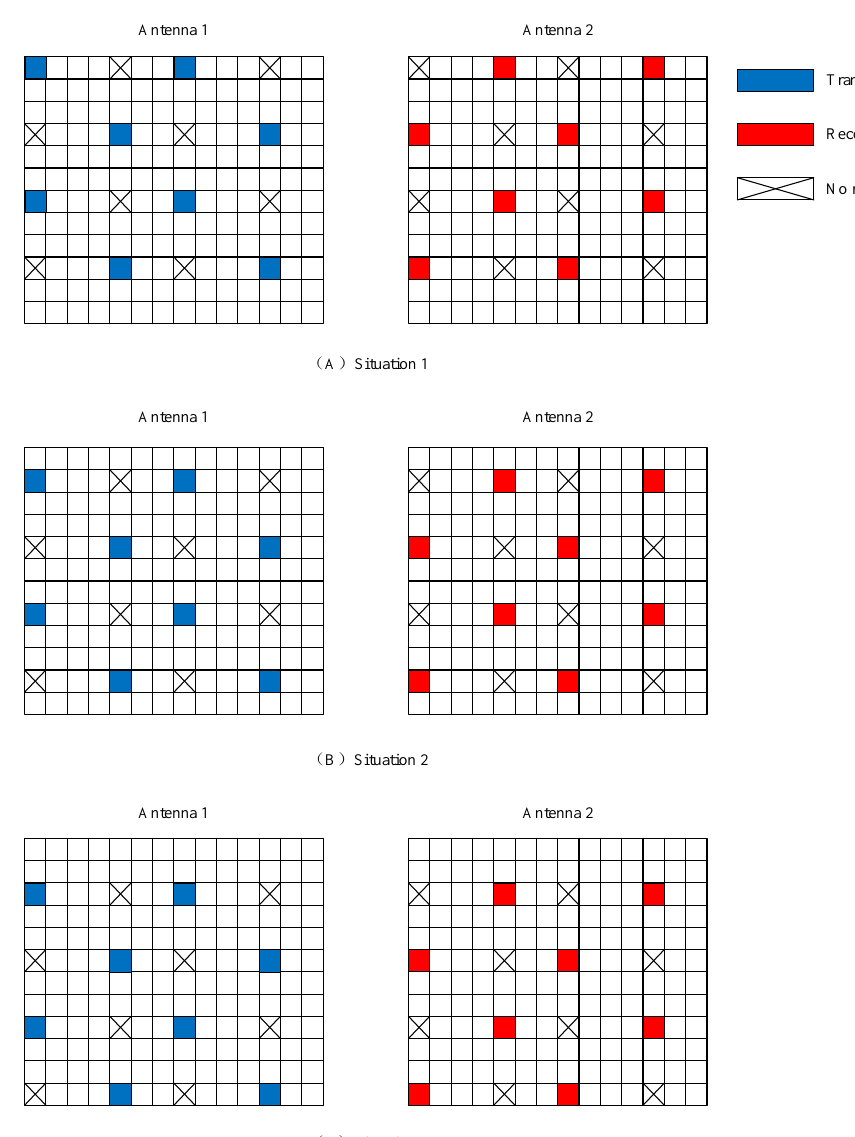
Figure 5. Positions of CRS within RB.